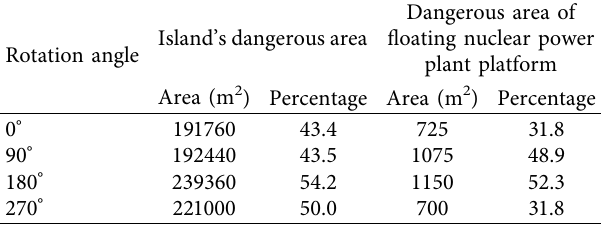
Table 5: The dangerous area and proportion after rotating at the western